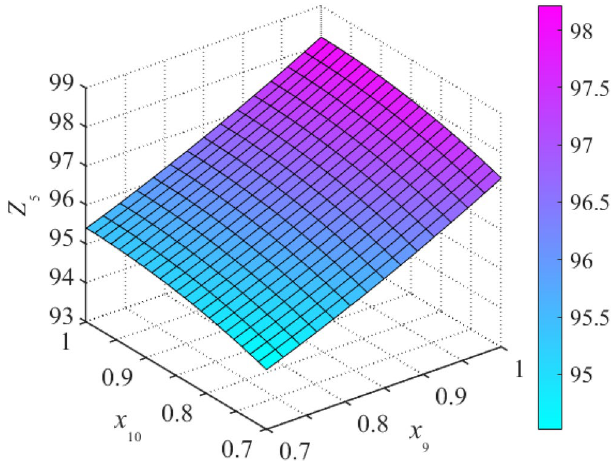
Figure 5. Response surface of frequency Z 5 about x 9 and x 10 .